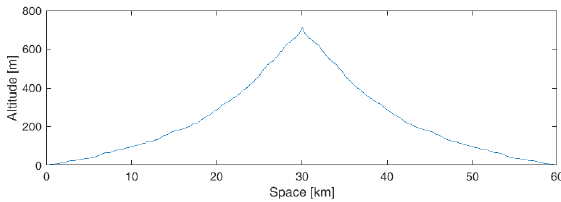
Figure 19. Altitude profile, mountain mission 2.